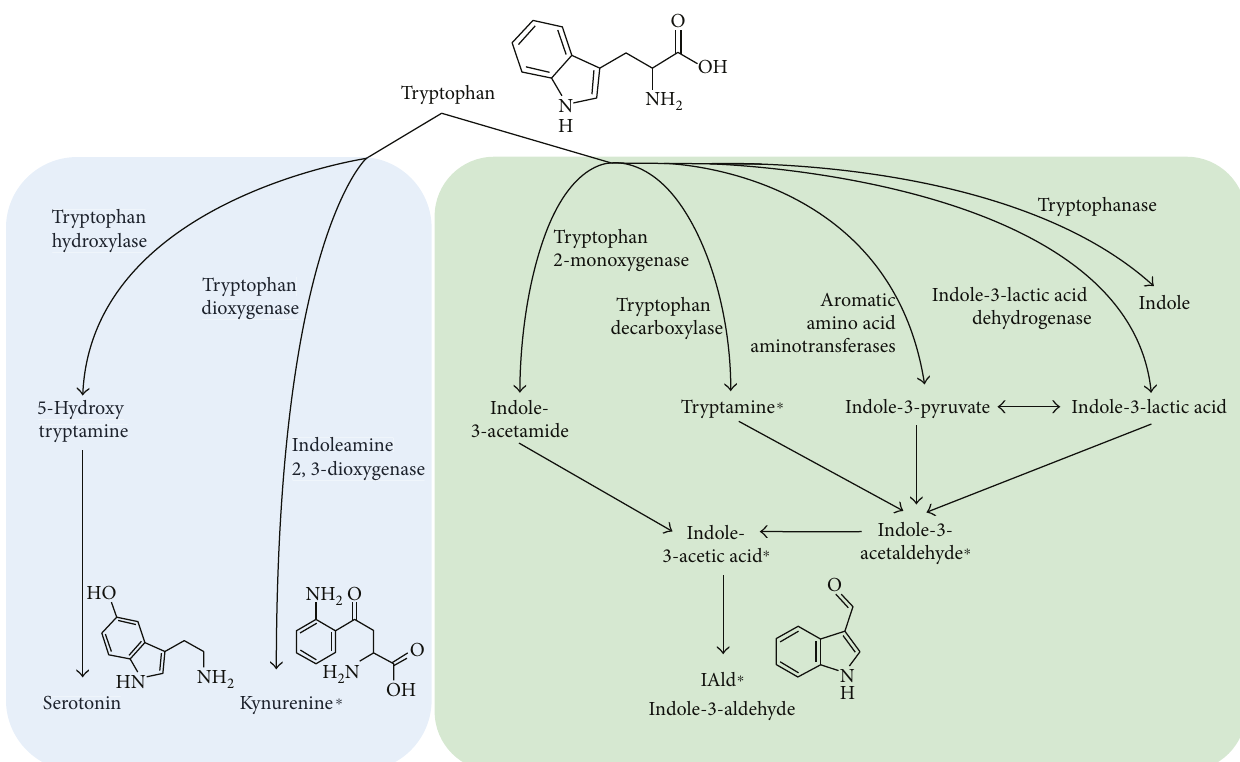
Figure 2: Tryptophan metabolic pathways. The image shows enzymes involved in the host ’ s pathways (on the left) and microbial pathways (on the right) of tryptophan metabolism. Asterisks indicate metabolites with AhR agonistic